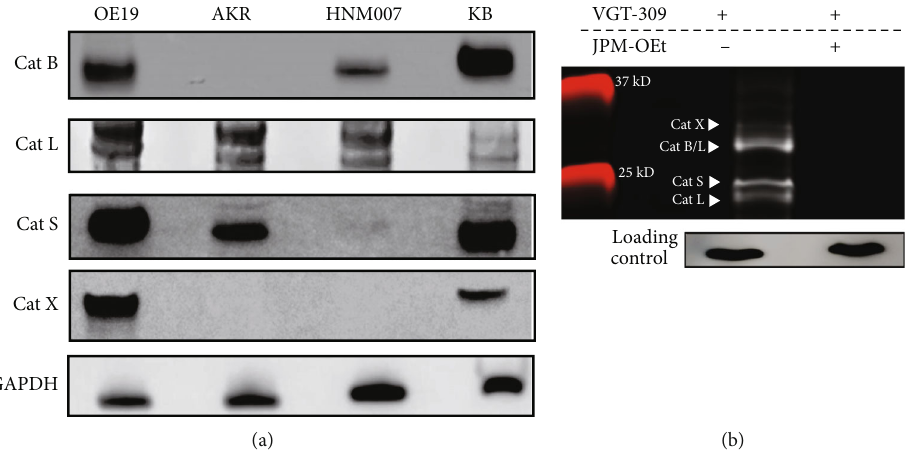
Figure 2: Esophageal carcinoma cell lines express cathepsins that are fl uorescently labeled by VGT-309. (a). Western blot analysis of cathepsin expression in esophageal cancer cell lines with KB (human cervical carcinoma) used as a positive control. (b). SDS-PAGE analysis of probe-labeled species in OE19 (human esophageal adenocarcinoma) cells with and without pretreatment with 100 μ M JPM- OEt, a broad spectrum cathepsin